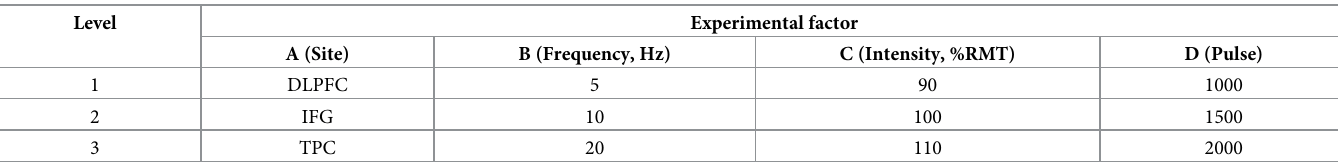
Table 1. The orthogonal experimental factors and levels of rTMS.